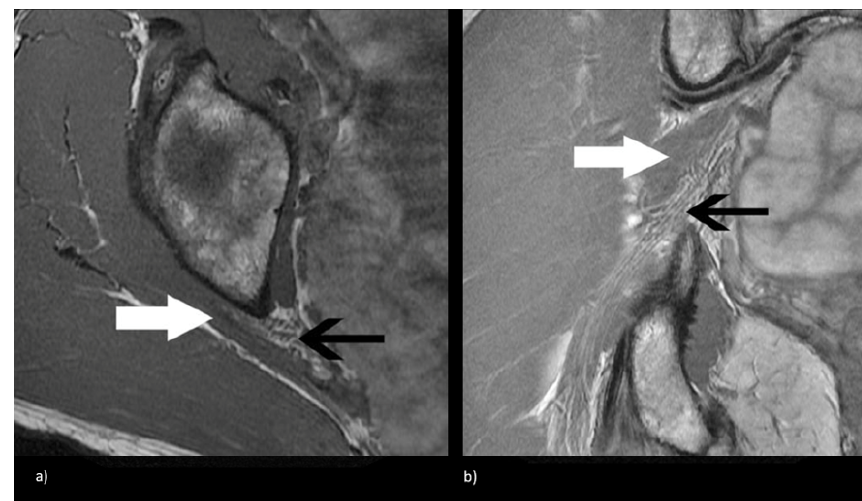
Figure 2. Magnetic resonance neurogram (MRN) of non-split sciatic nerve (type I). ( a ) Axial T1- weighted MRN of the sciatic nerve at the level of the sciatic notch demonstrates normal sciatic nerve (black arrow) anterior to the piriformis (white arrow). ( b ) Coronal T1-weighted sequence showing type I sciatic nerve (black arrow) inferior to the piriformis (white arrow).